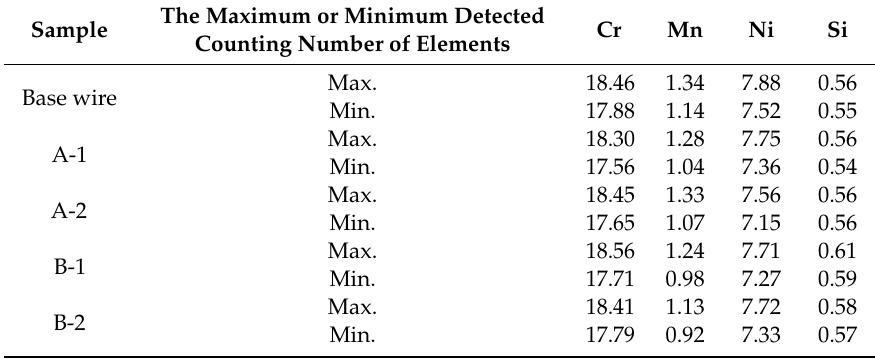
Table 3. The maximum and minimum values of the EDS results for the tested samples.